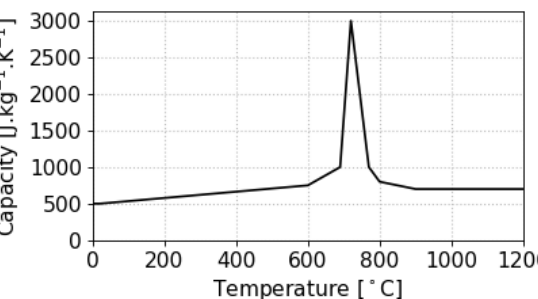
Figure 11. EC3 Steel specific heat